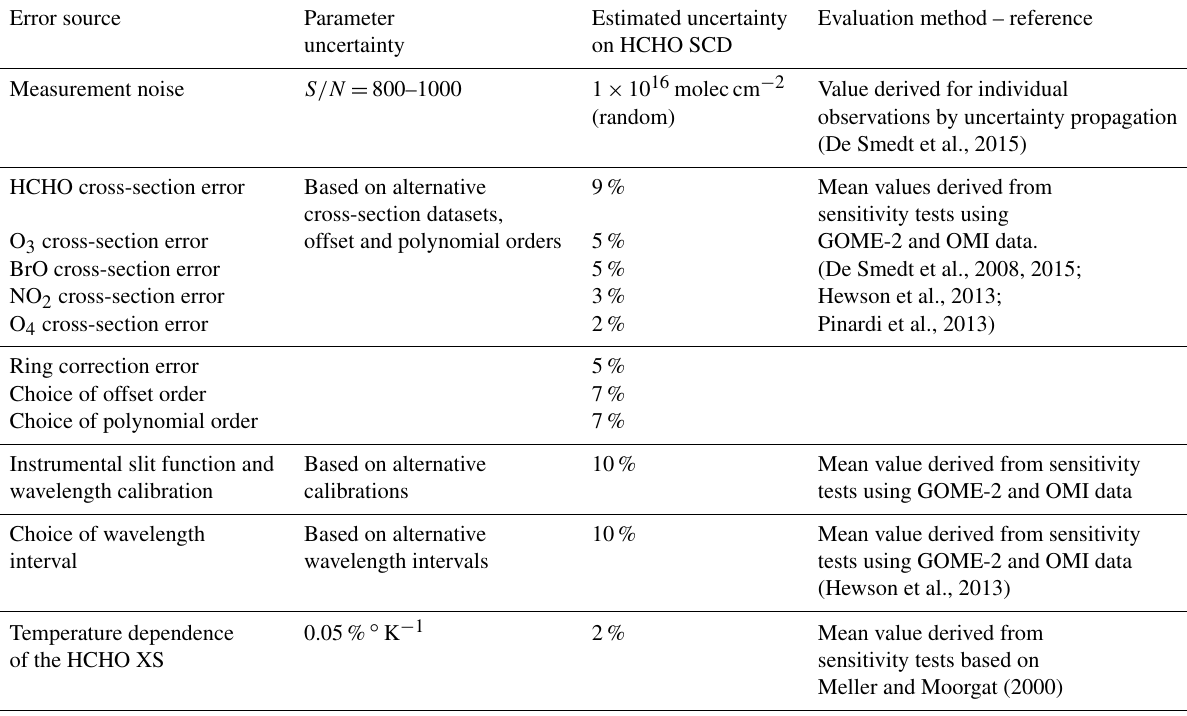
Table 7. Summary of the different error sources considered in the HCHO slant column uncertainty budget.